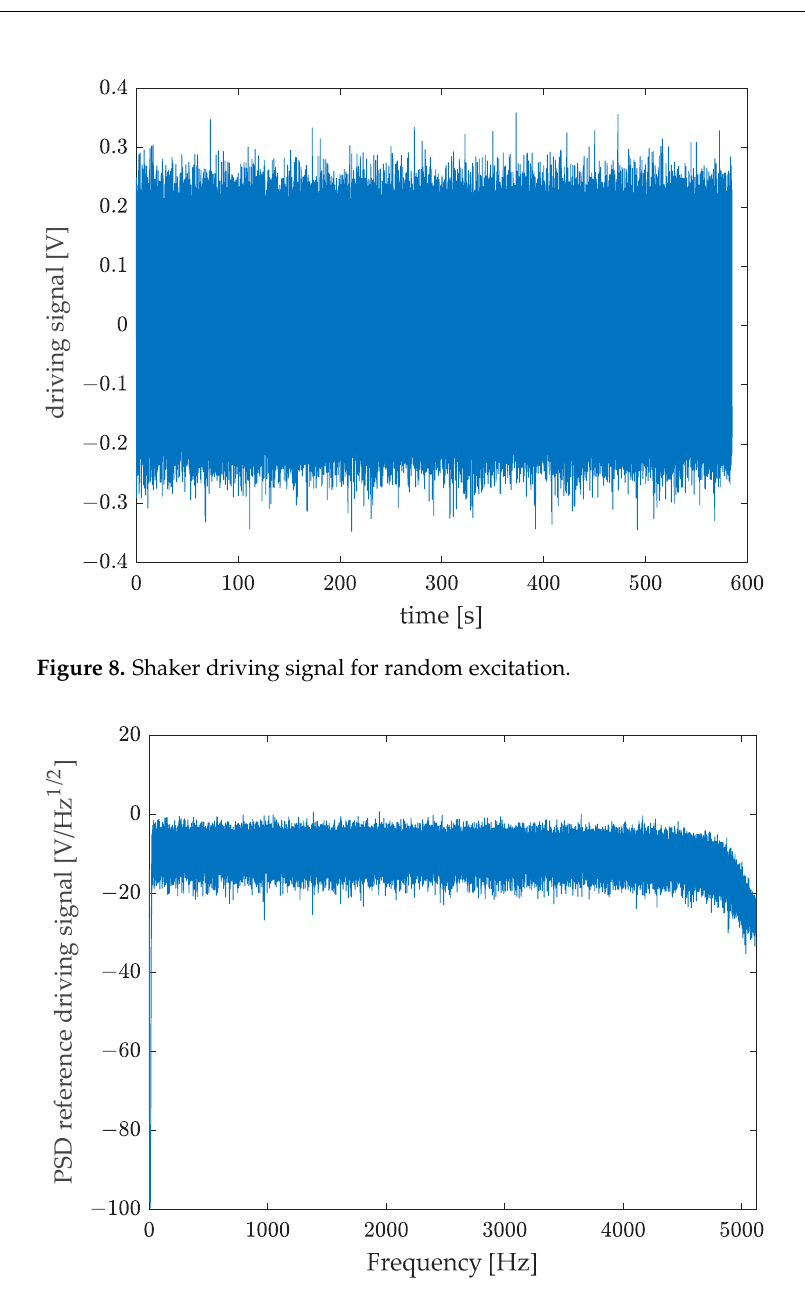
Figure 7. The experimental setup.